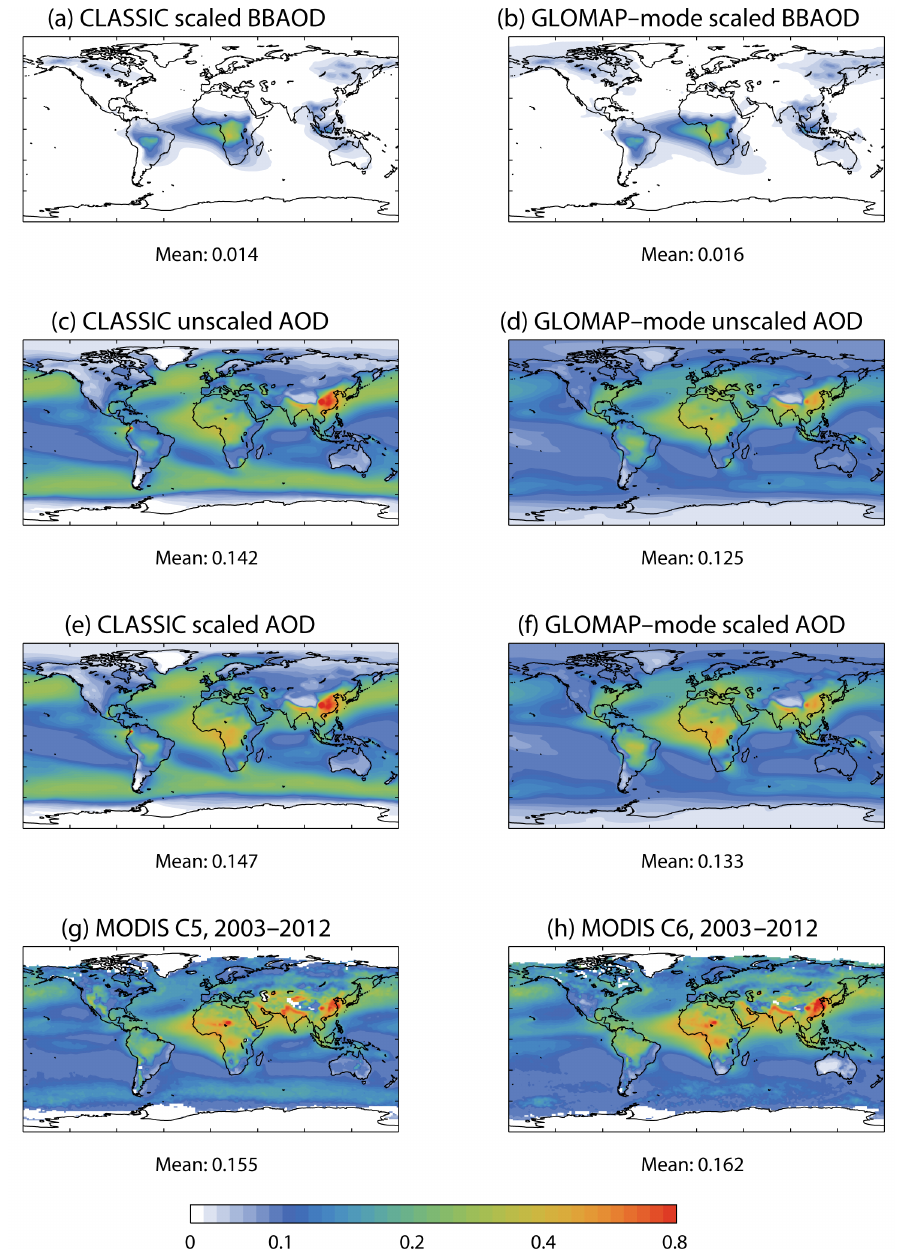
Figure 2. Decadal mean AOD at 550nm. Panels include (a, b) BB AOD, the contribution of BBA emissions to the total AOD in the standard (scaled) simulations; (c, d) unscaled model AODs are from simulations that did not include scaling of BB aerosol emissions; (e, f) model AOD from the standard (scaled) simulations; (g, h) MODIS data from Aqua collections 5 and 6, averaged from 2003 to 2012. Model means from 2002 to 2011. Missing data values from MODIS are plotted as